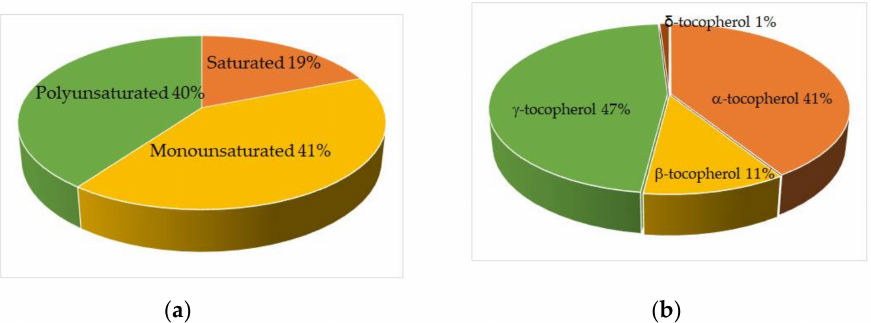
Figure 1. Lipid constituents of Ginkgo biloba nuts (crop 2019): ( a ) Relative part of saturated, monoun- saturated, and polyunsaturated fatty acids in oil; ( b ) Individual tocopherol composition. The total amount of tocopherols was 192.6 mg/100 g oil. Chromatographic quantifi- cation of the individual tocopherols showed that, as with most nuts, γ - and α -tocopherol dominated and were approximately equally represented (Figure